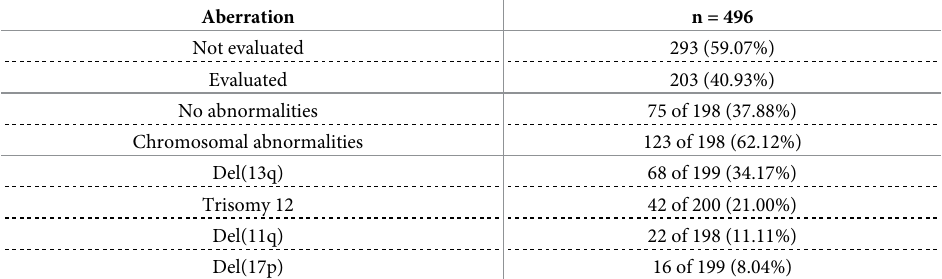
Table 2. Prevalence of chromosomal aberrations on CLL patients detected by